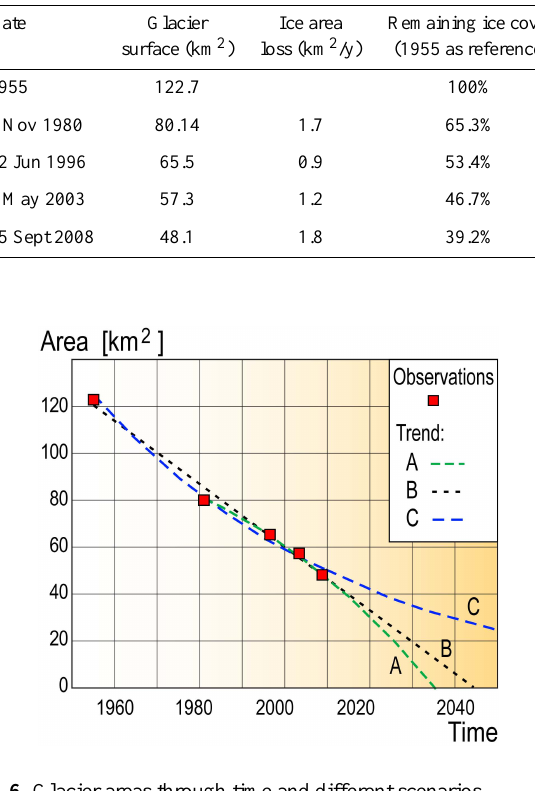
Fig. 6. Glacier areas through time and different